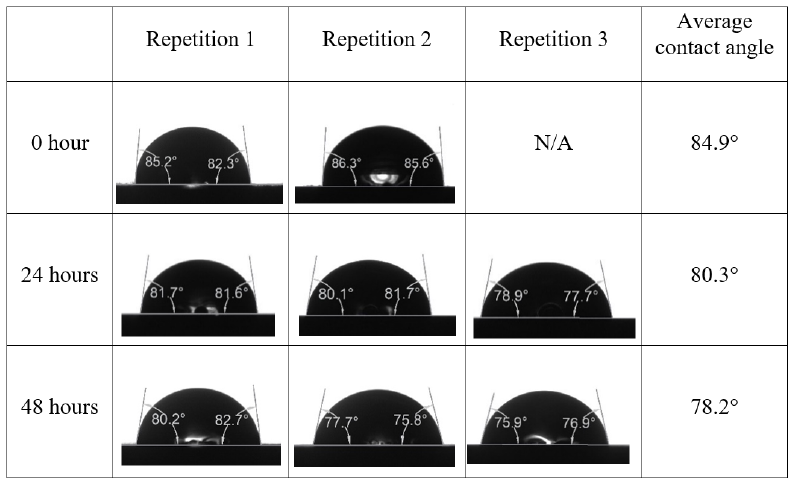
Figure A4. Dynamic Contact Angle Measurement Results for MgCl 2 (3500 ppm).